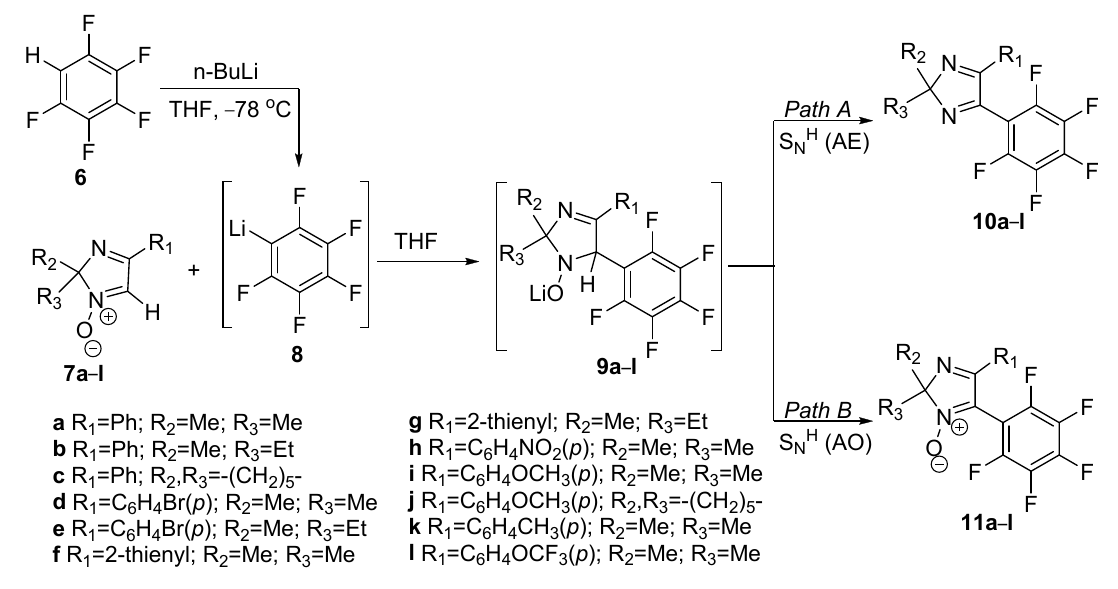
Table 1. Fluorescent properties of the selected 5aa and 5ba in DMSO.